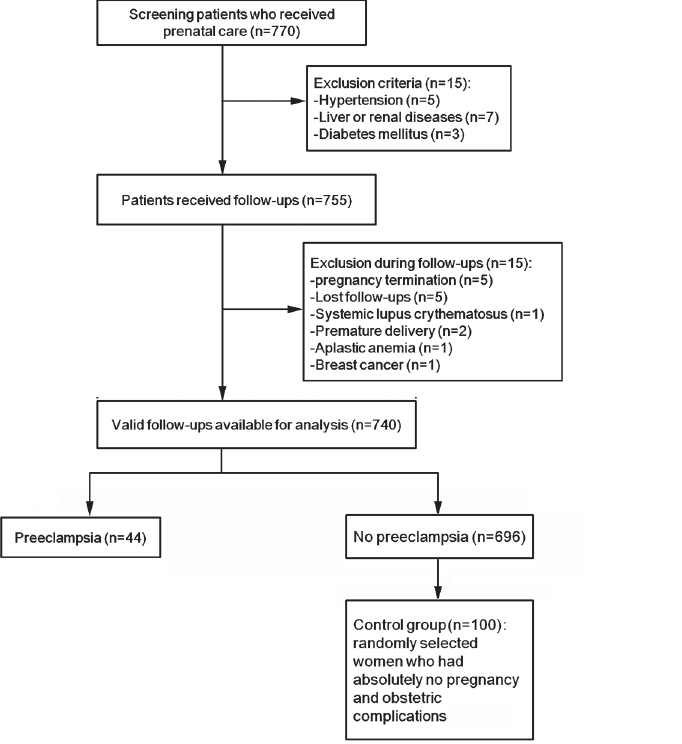
Fig 1. Study flowchart.